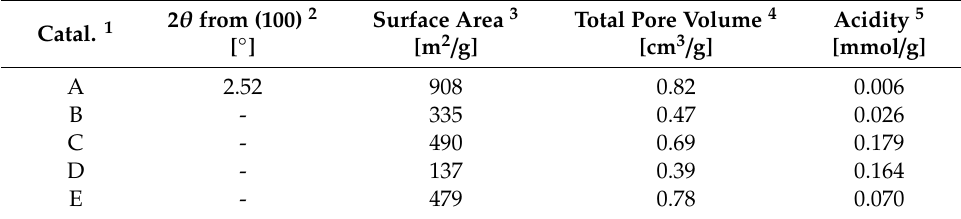
Table 2. Information concerning the structure, surface properties, and acidity of MCM-41 and related